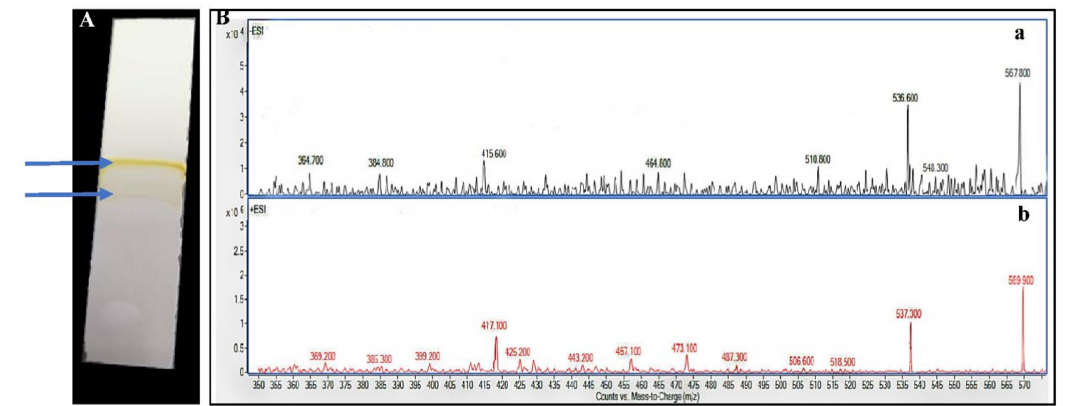
Figure 9. TLC plate ( A ) and LC mass spectral analysis of the pigment extracted from halophilic V. halodenitrificans DASH ( B ). For TLC, silica gel GF254 plate (Merck, Darmstadt, Germany); mobile phase: petroleum ether: acetone (80:20). For LC–MS, negative ionization scanning mode (350–600 Da) (a) negative (-ESI) and (b) positive ionization scanning mode